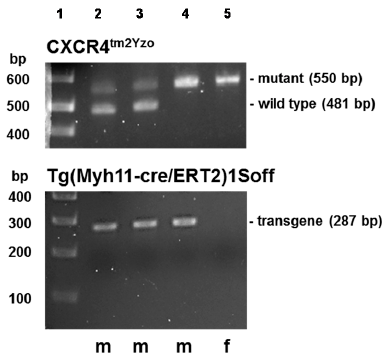
Figure 3. Genotyping of transgenic mice. Lane 1 : molecular weight markers; Lanes 2 and 3 : males, heterozygous for the CXCR4 loxP allele carrying the CreER T2 transgene on the Y chromosome; Lane 4 : male, homozygous for the CXCR4 loxP allele carrying the CreER T2 transgene in the Y chromosome = experimental animals; Lane 5 : female, homozygous for the CXCR4 loxP allele.